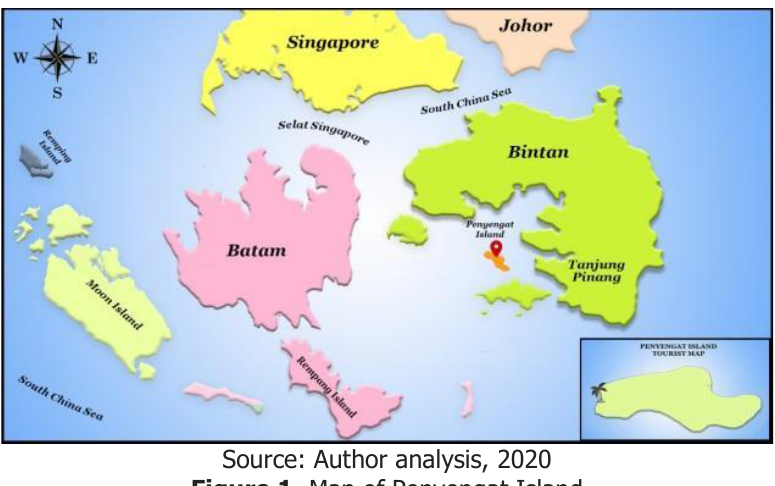
Figure 1. Map of Penyengat